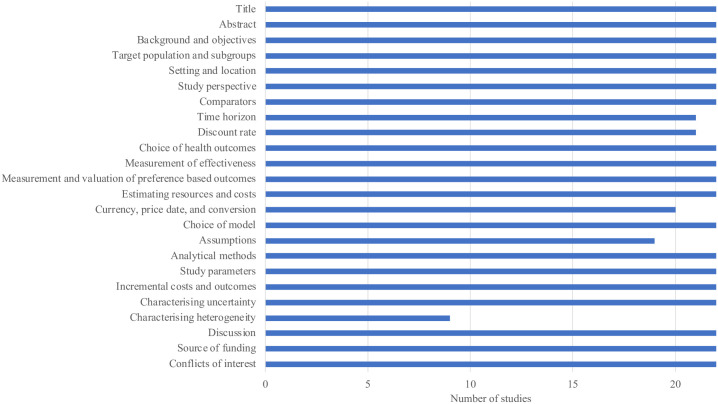
Number of included studies that met each CHEERS criterion.